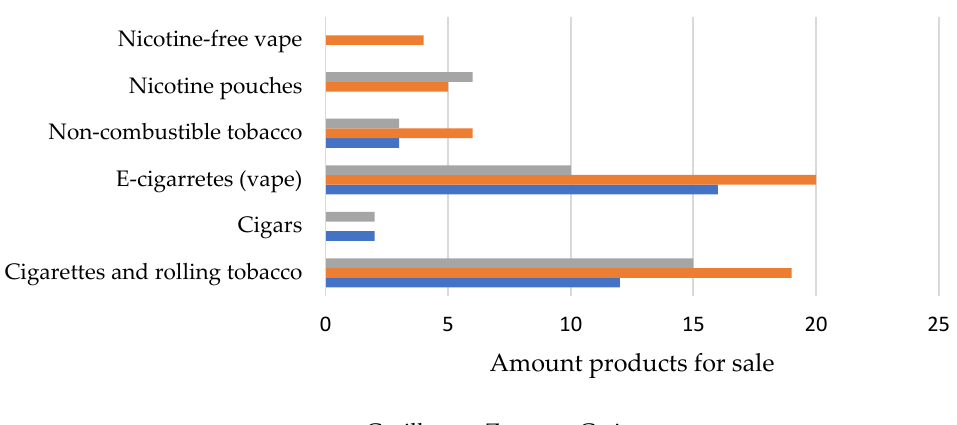
Figure 1. Alcoholic beverages sold by dark grocers [November 2021].